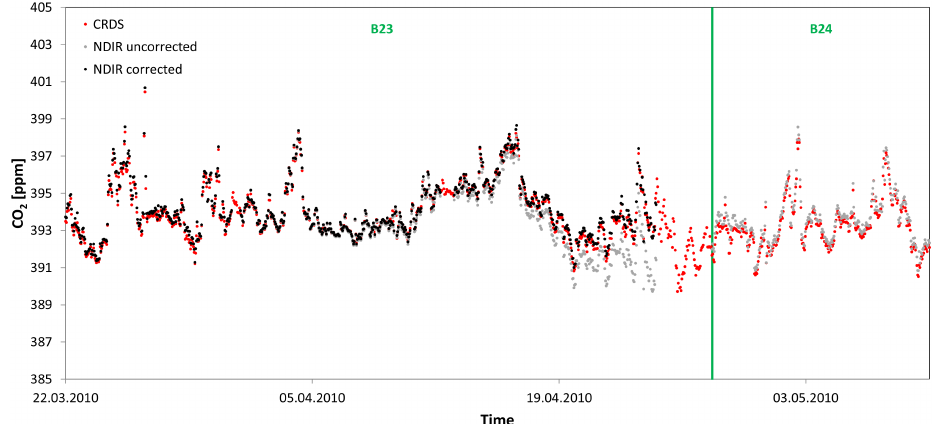
Figure 7. Time series of the CO 2 mole fractions determined with CRDS (red points) and NDIR (uncorrected in grey, after correction in black). The desorption-corrected NDIR CO 2 values show a much better agreement with the CRDS CO 2 values than the uncorrected, which are severely underestimated towards the end of the B23 period. After replacement of the working gas cylinder B23 with B24, the uncorrected NDIR CO 2 values show a much better agreement with the CRDS CO 2 values.